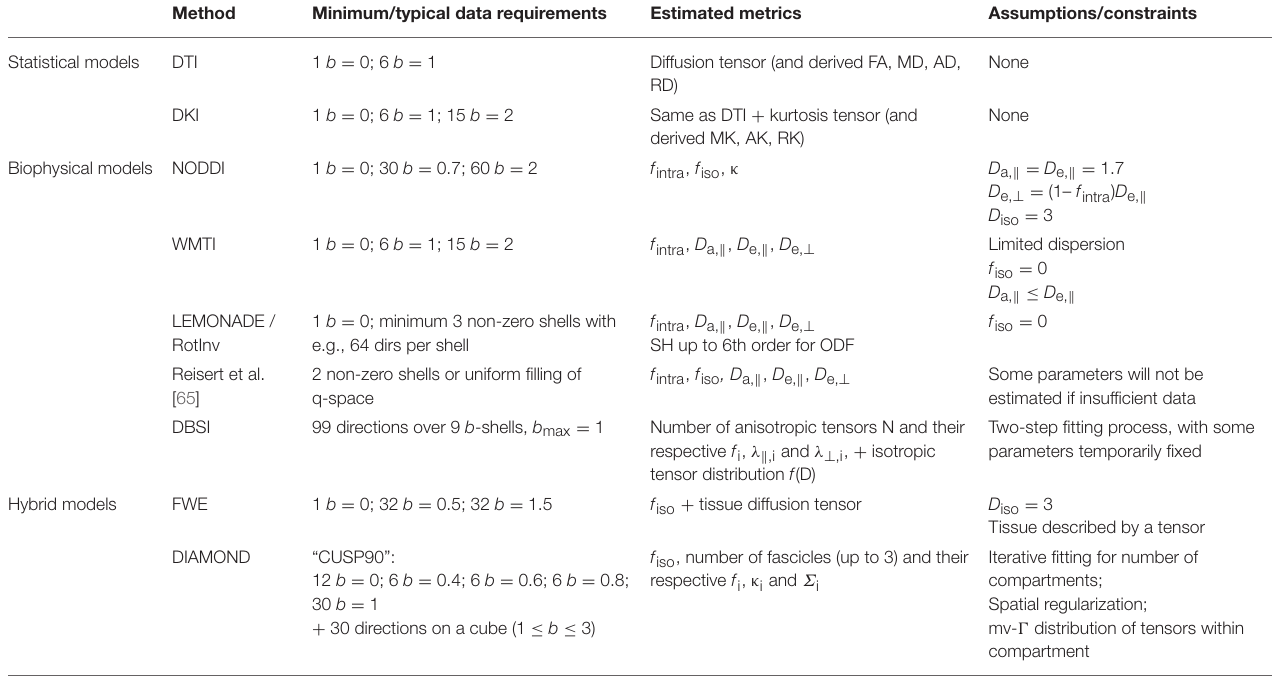
TABLE 1 | Summary of method